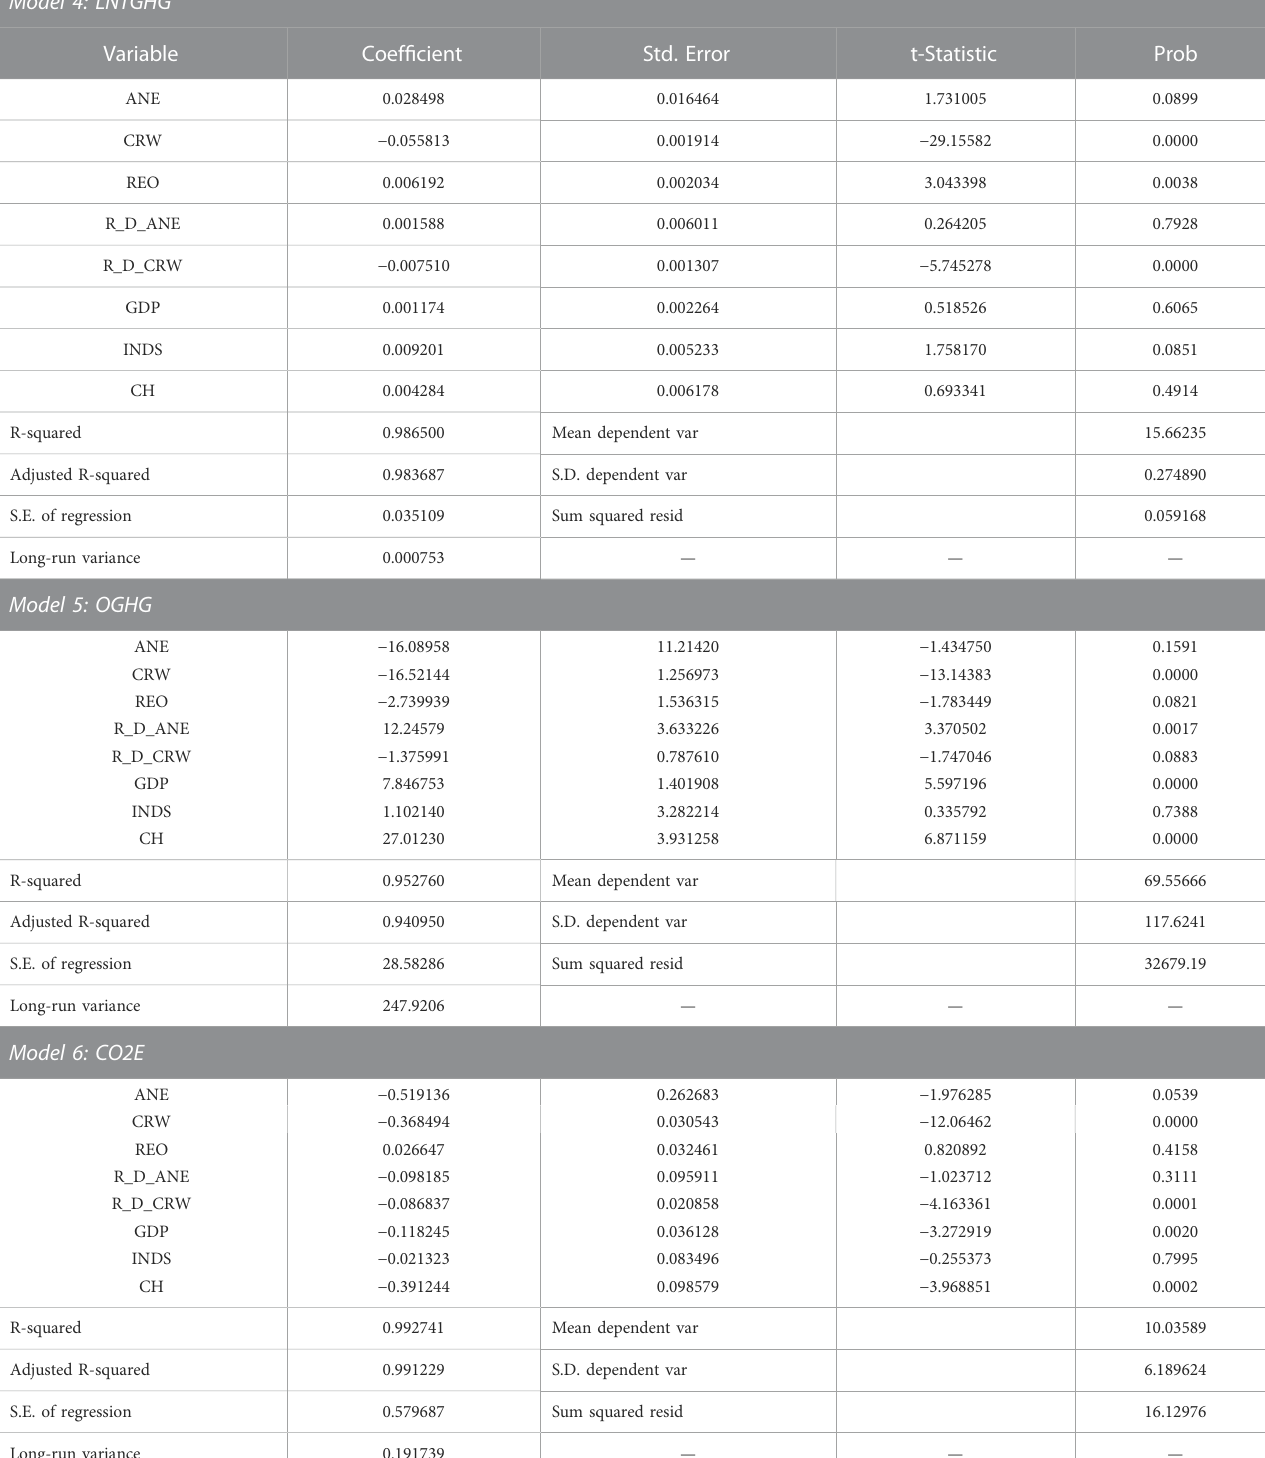
TABLE 9 the moderating effect of R&D. Model 4: